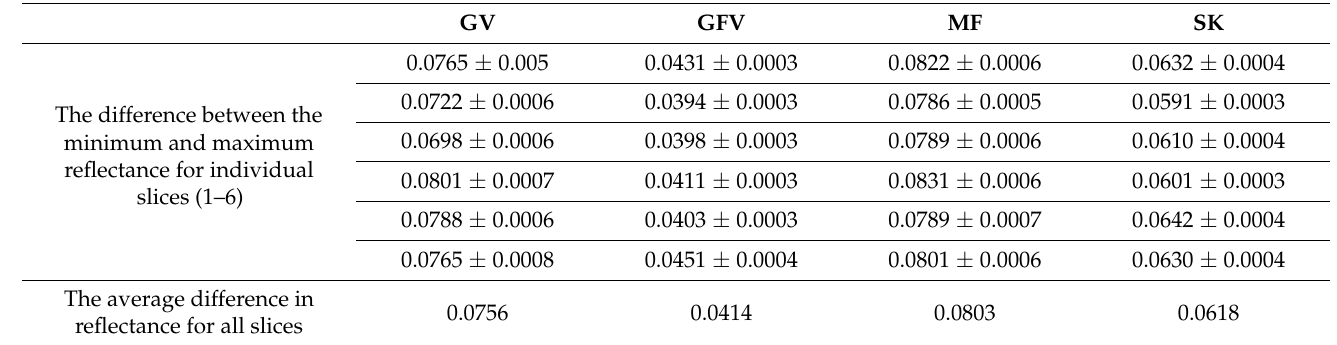
Figure 12. Exemplary hyperspectral profiles of individual slices for the GV sample. Blue, red and green correspond to the maximum, average and minimum reflectance, respectively. ( a – f ) correspond to successive slices by the tested sample. Table 3. The difference between the maximum and minimum reflectance for all chocolate samples within one slice.